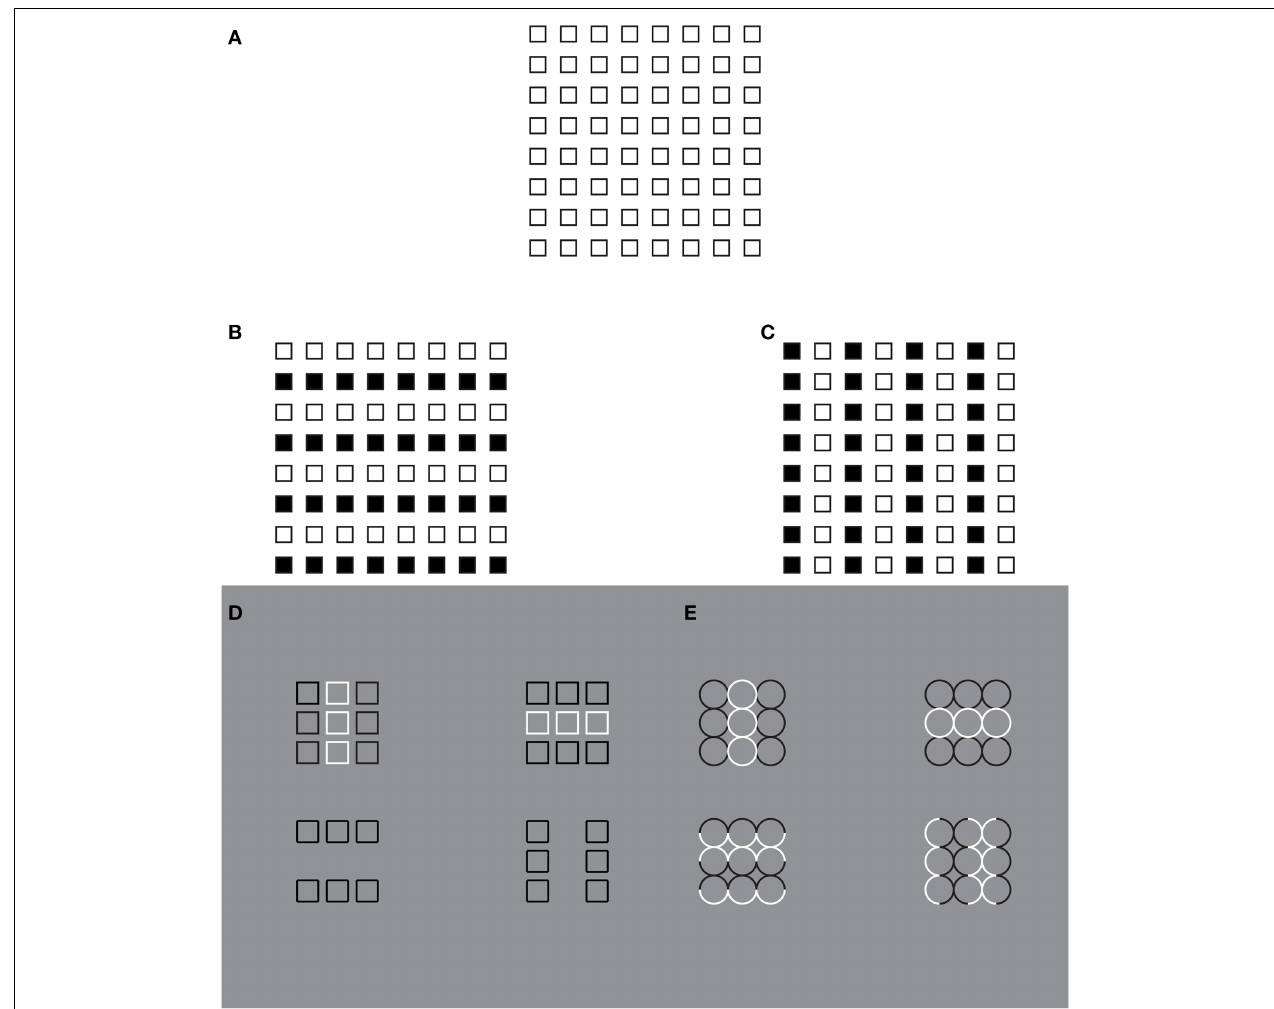
FIGURE 1 | Thegroupingdirection“deforms”boththesmallandthelargesquaresbywidening/lengtheningtheirbaseandcreatinghorizontal/vertical rectangles. This phenomenon was called “ rectangle illusion .” Similar effects can be perceived in the circles. For further details please see the